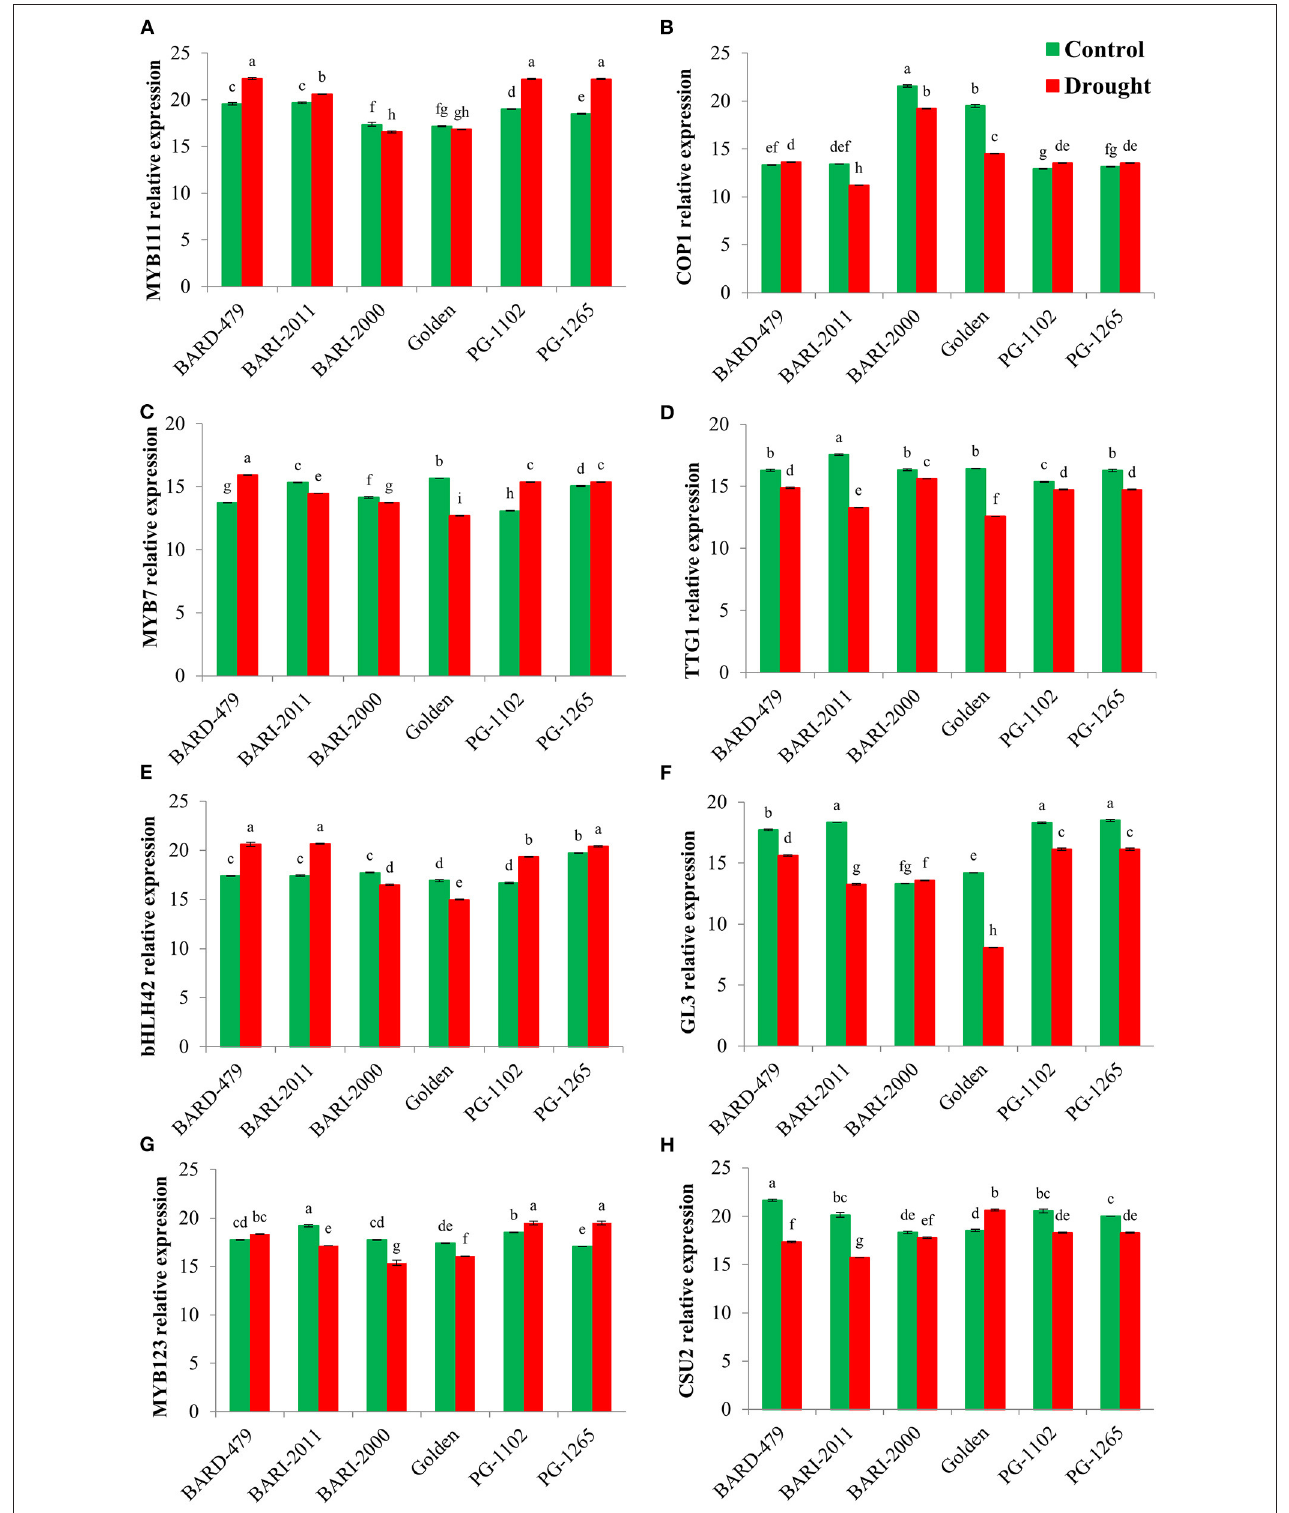
FIGURE 6 | Transcription factors expression profile in roots of genotypes of peanus under drought stress. The panel shows the following: the MYB111 (A) , the COP1 (B) , the MYB7 (C) , the TTG1 (D) , the bHLH42 (E) , the GL3 (F) , the MYB123 (G) , and the CSU2 (H) . Data are shown as the interaction between the peanut genotypes and the drought applied. Significance was inferred either with an ANOVA under the Tukey’s HSD post-hoc test for normally distributed data (Honest Significant Detection, p < 0.05). Non-parametric data were analyzed with a Kruskal–Wallis test under False Discovery Rate post-hoc correction (FDR, p < 0.05).